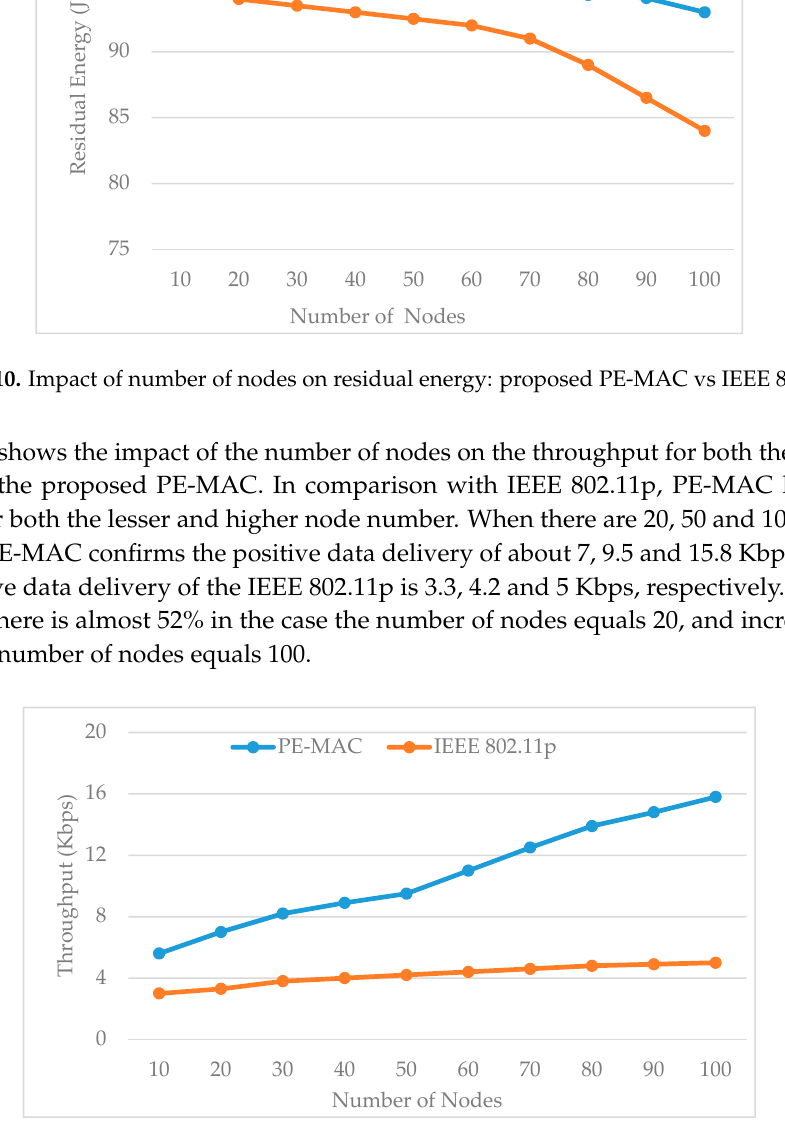
Figure 9. Impact of inter packet transmission interval on average end-to-end delay: proposed PE- MAC vs IEEE 802.11p.